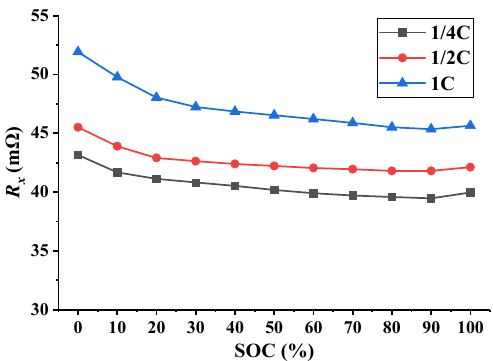
Figure 11. Battery resistance at various SOC values and C-rates.